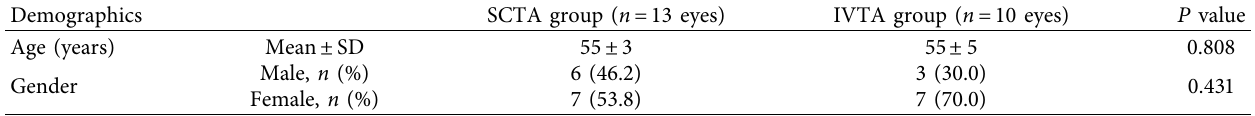
Table 1: Demographic characteristics in both